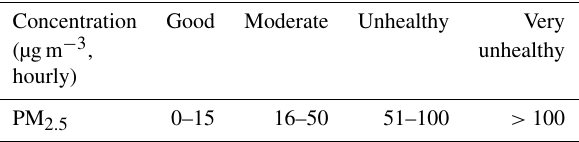
Table 2. Air quality index